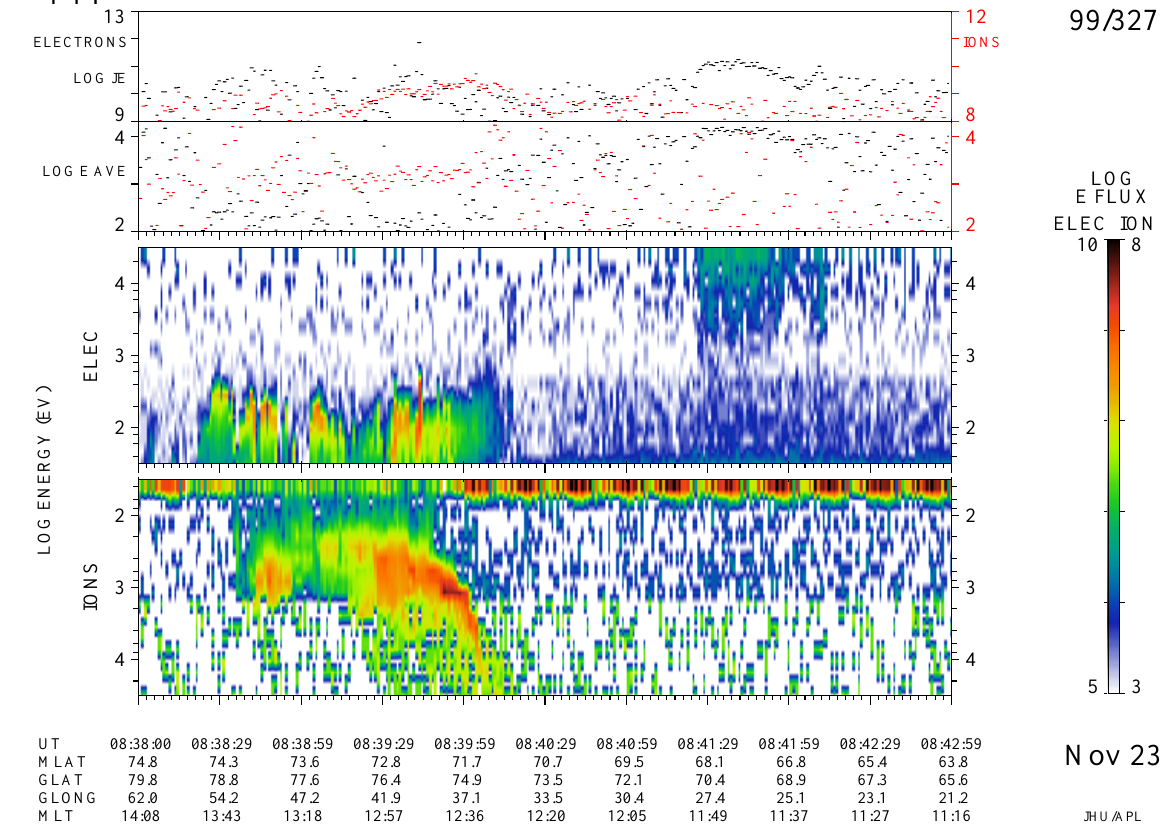
Fig. 6. Same as Fig. 5, showing a noon pass of DMSP-F14 through the footprint of an active reconnection site near 12:30 MLT.